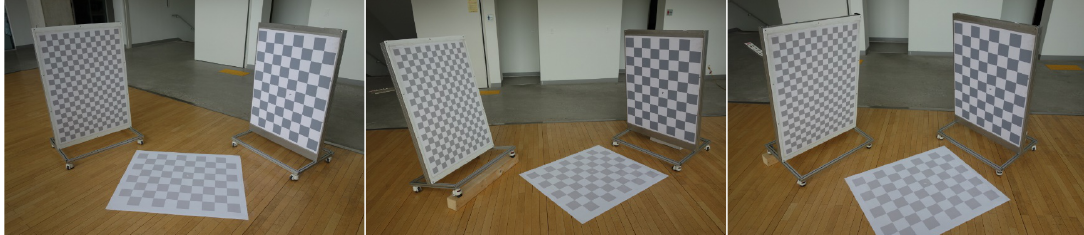
Figure 6. Three non-parallel planes in three different configurations are captured by the sensor system in Figure